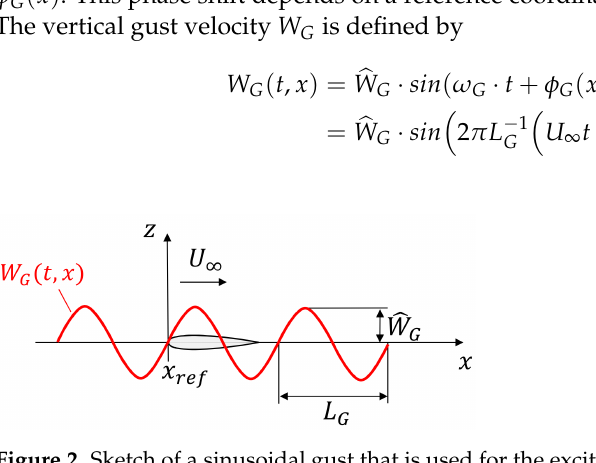
Figure 2. Sketch of a sinusoidal gust that is used for the excitation of the flow. Gust lengths are varied between 2.5 m and 125.5 m, which results in reduced frequen- cies k of 2.51 down to 0.05 using l ref = c :